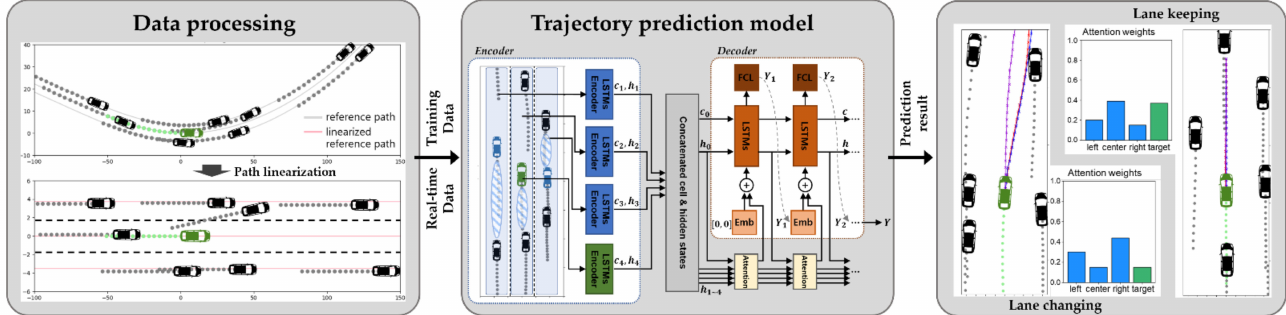
Figure 1. Framework of the proposed vehicle trajectory prediction